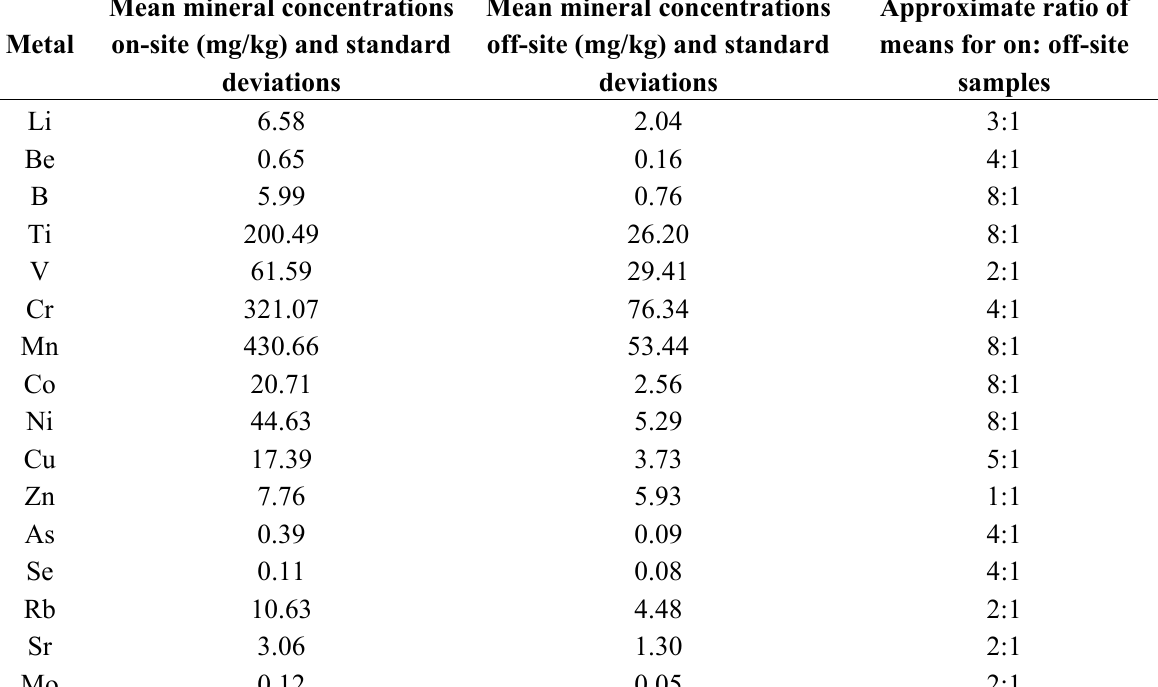
Table 1. Mean mineral concentrations on- and off-